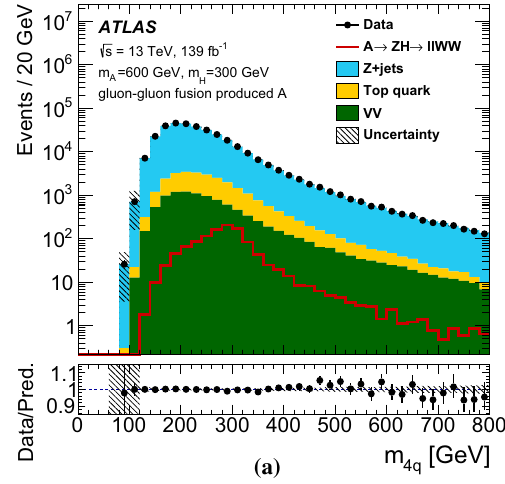
Fig. 11 The m 4 q distribution before any m 4 q window cuts. The same conventions as in Fig. 4 are used of the m 4 q window requirement are shown in Fig. 12a, b, referring to m 4 q windows defined for m H = 300 GeV and m H = 500 GeV, respectively. Signal distributions